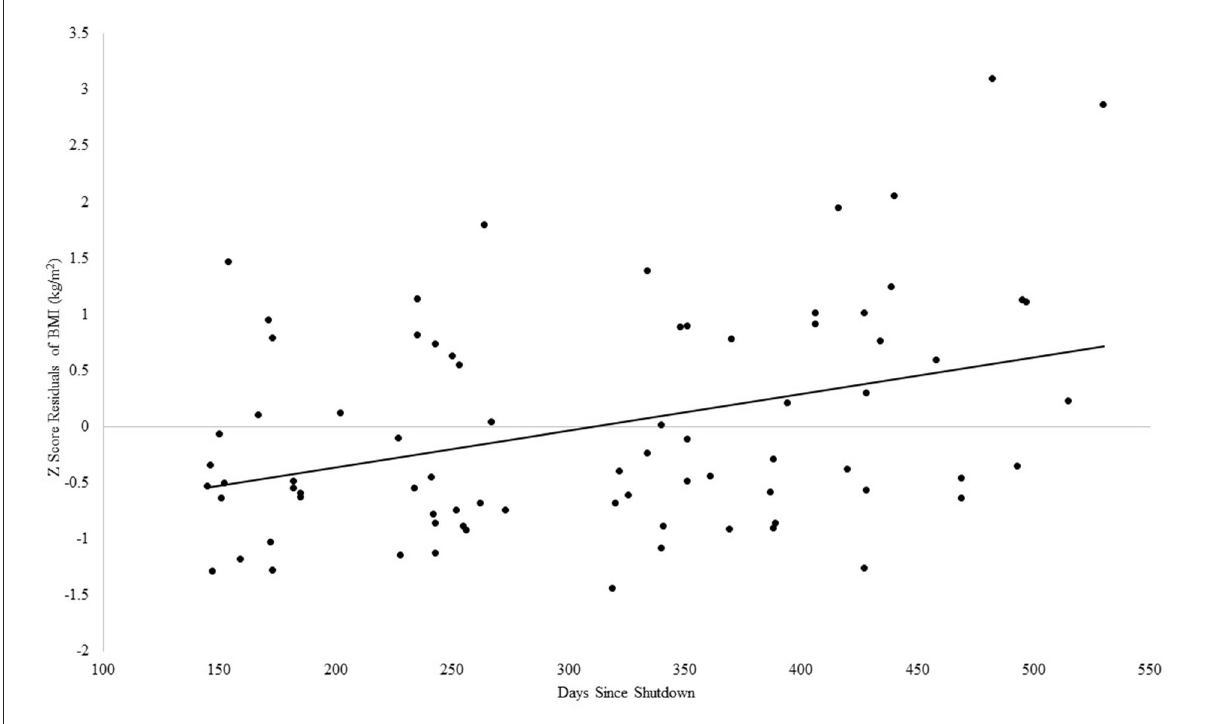
FIGURE6 Association between days since COVID-19 shutdown and BMI in